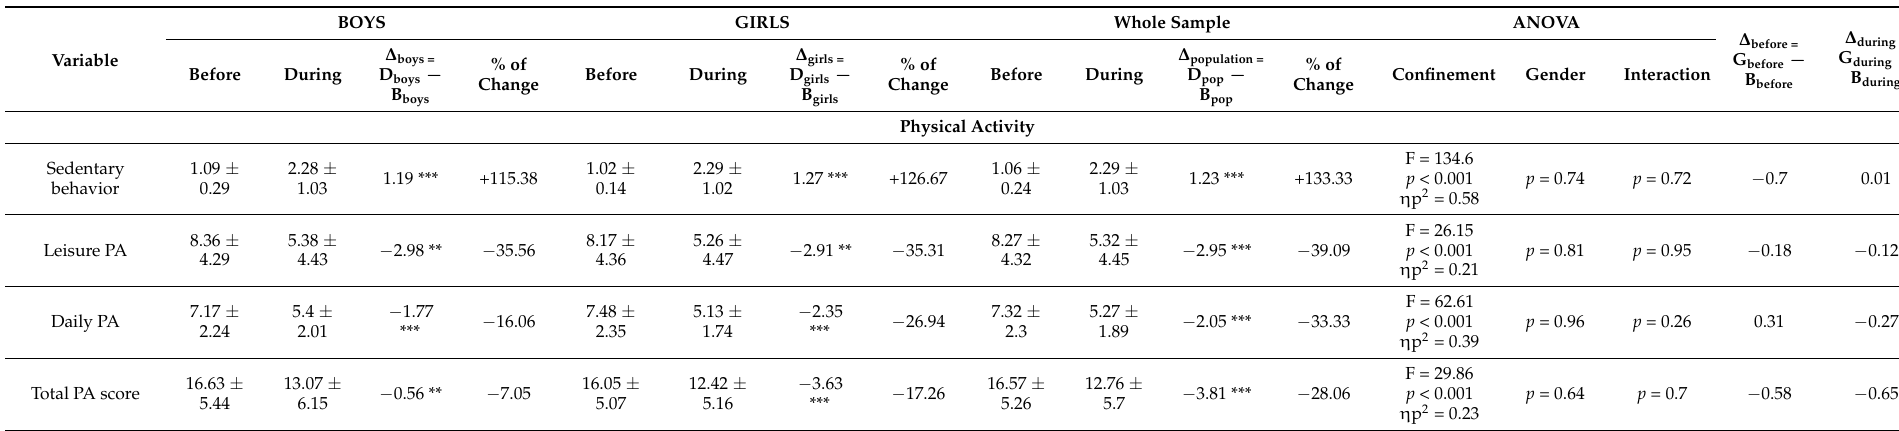
Table 4. Responses to level of PA before and during